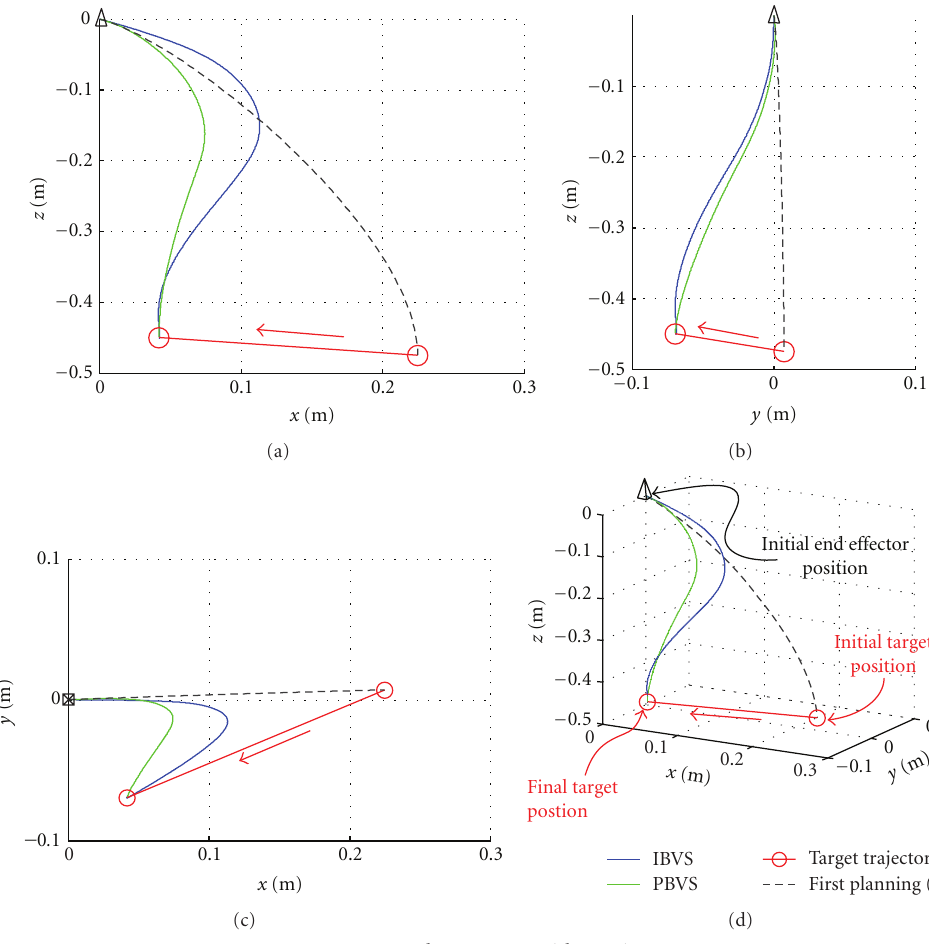
Figure 11: IBVS and PBVS tests with moving